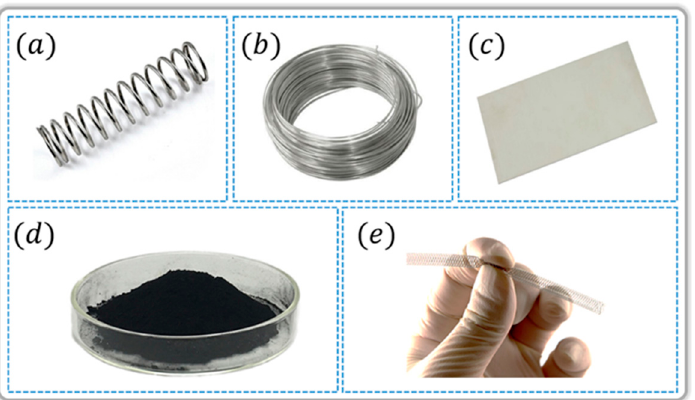
Figure 3. Various forms of commercially available NiTi: ( a ) spring, ( b ) wire, ( c ) thin film, ( d ) nanoparticles, ( e ) stent (demonstrating squeezing of a self-expanding braided NiTi stent used for endovascular surgery) [12].